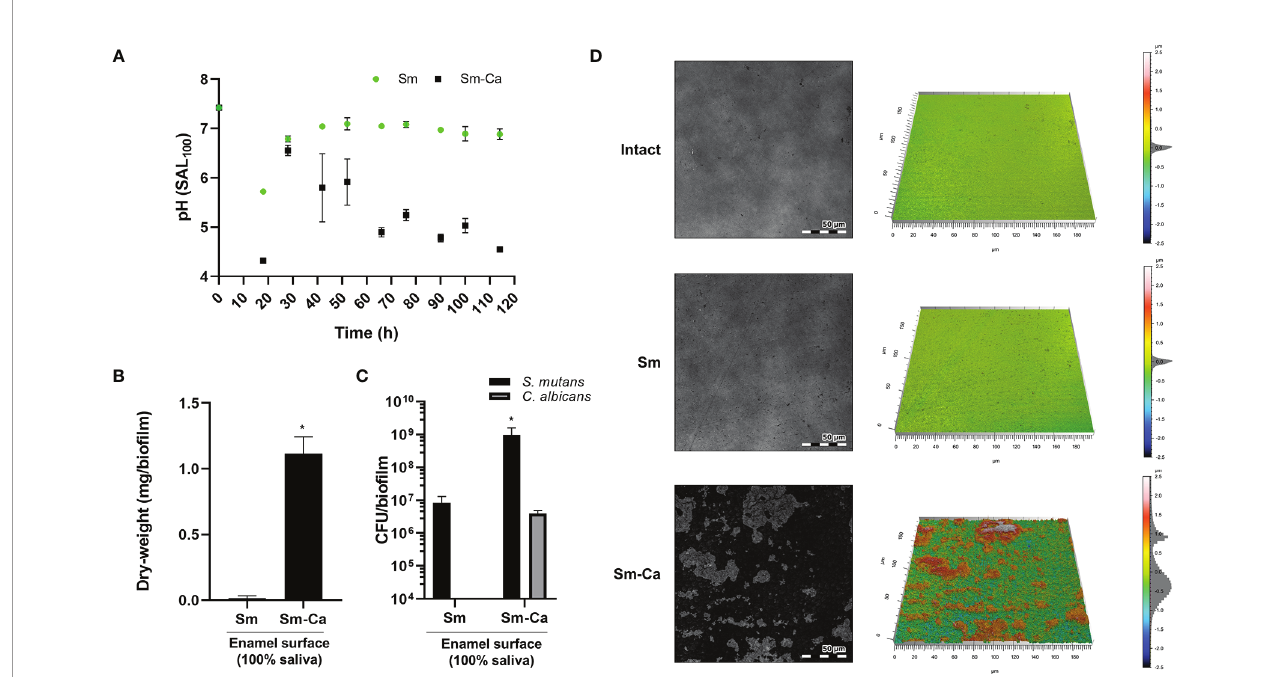
FIGURE 5 | Demineralization of human enamel surface by Sm and Sm-Ca bio fi lm in SAL 100 . (A) pH changes in Sm and Sm-Ca bio fi lm throughout the bio fi lm experiment. (B) Biomass (Dry-weight) of bio fi lms and (C) CFU of S. mutans and C . albicans in Sm and Sm-Ca bio fi lms at fi nal phases (114 h). (D) Representative confocal surface-topography and roughness of enamel surfaces (Scale bar: 50µm). Asterisk indicates that the p -values are signi fi cantly different from Sm bio fi lm (Student ’ s t -test; * P < 0.05).